Question: Author a descriptive caption for the visualization shown.
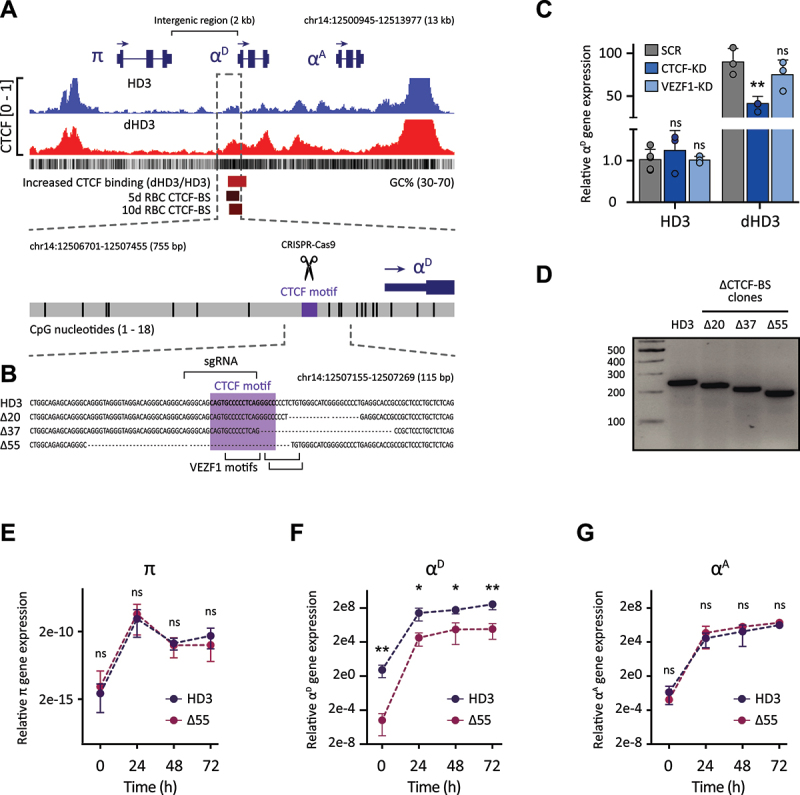
Answer: The CTCF-BS is critical for the transcriptional activation of α D . (A) Genomic snapshot showing the CTCF signal tracks for HD3 and dHD3 at the chicken α-globin locus. The inset boxes show CTCF peaks for dHD3, 5-day red blood cells (5d RBCs), and 10-day red blood cells (10d RBCs). A zoomed-in view of the intergenic region between the π- and α D -globin genes shows the position of the CTCF (purple box) motif deleted by CRISPR-Cas9. Vertical black lines represent the positions of CpG nucleotides along the intergenic region analyzed. (B) Multiple alignments showing the sequences of the ΔCTCF-BS clones (Δ20, Δ37, and Δ55) compared to HD3 cells. Sequences were obtained by PCR amplification and Sanger-mediated DNA sequencing. The positions and sequences of the sgRNA and motifs are pointed out. (C) Transcript abundance of α D determined by RT-qPCR analysis in HD3 and dHD3 cells. RNA abundance for each condition (CTCF-KD or VEZF1-KD) was normalized to the scramble (SCR). (D) DNA gel electrophoresis analysis of PCR-based screening for HD3 and ΔCTCF-BS clones. (E-G) Kinetics of gene expression for the α-globin genes during erythroid maturation over a 72 h time course. Data are presented as mean ± SEM, with bars and dots representing results from at least three independent replicates. Significance was determined by an unpaired Student’s t -test as follows: (ns) not significant; * p < 0.05, ** p < 0.01, *** p < 0.001.